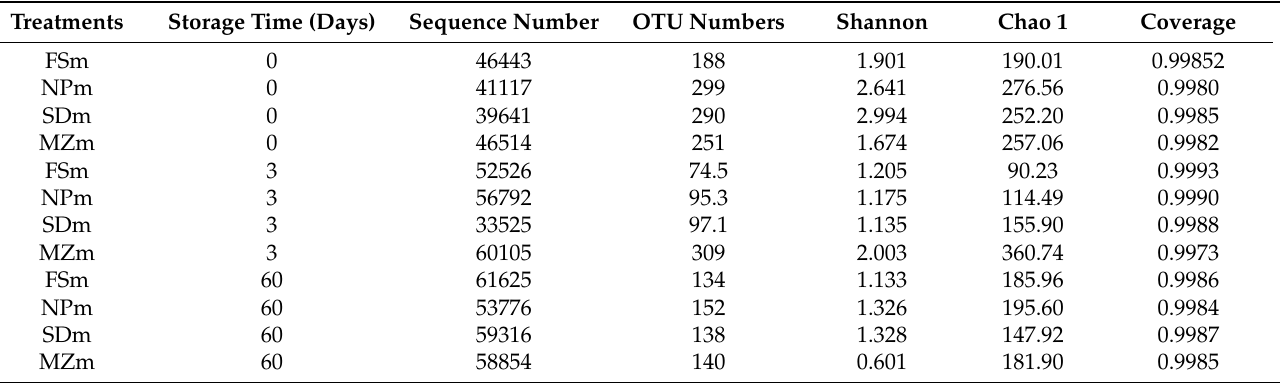
Table 6. Bacterial community richness and diversity indexes of the inoculum and silage samples of forage